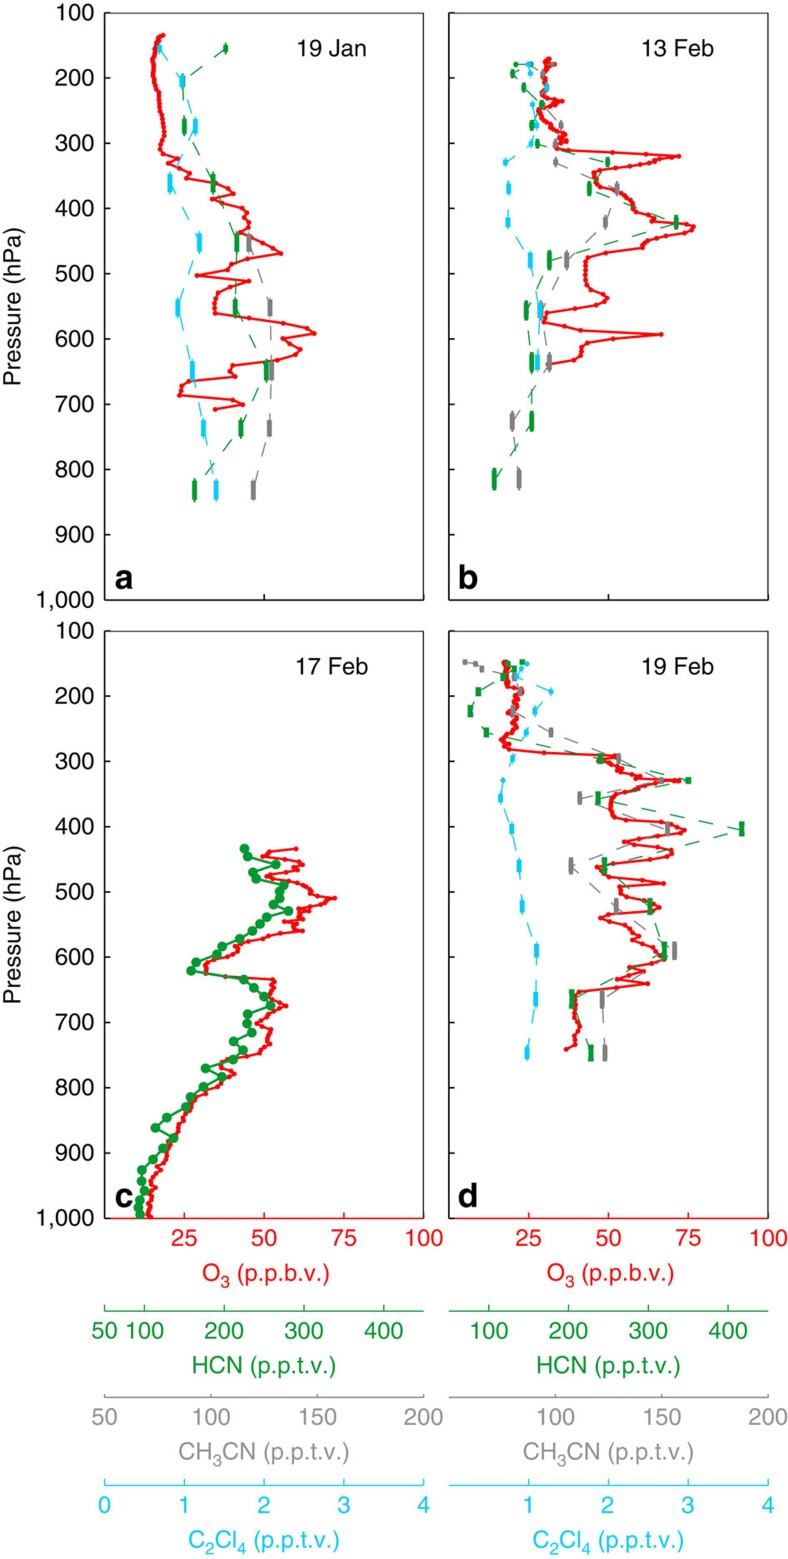
Anthropogenic tracers in the HOLW structures.Sample profiles from CONTRAST (a,b,d) and CAST (c) from the four flights shown in Fig. 2. O3 (red), CH3CN (grey), HCN (green) and C2Cl4 (light blue) are shown. O3 data are 10 s averages. CH3CN and C2Cl4 were not measured during CAST. CONTRAST HCN, CH3CN and C2Cl4 were sampled for 35 s at 2 min intervals. CAST HCN was sampled for 30 s. Vertical bars show the pressure range traversed during sampling.